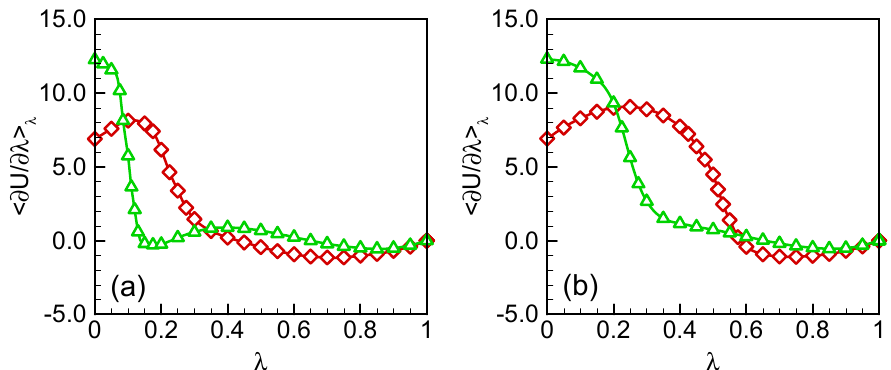
Figure 1. Formation energies of ( a ) self-interstitial ( b ) vacancy in germanium crystal. Red diamond and green delta symbols represent SW and Tersoff potential results, respectively. The lines are quadratic-fitted.